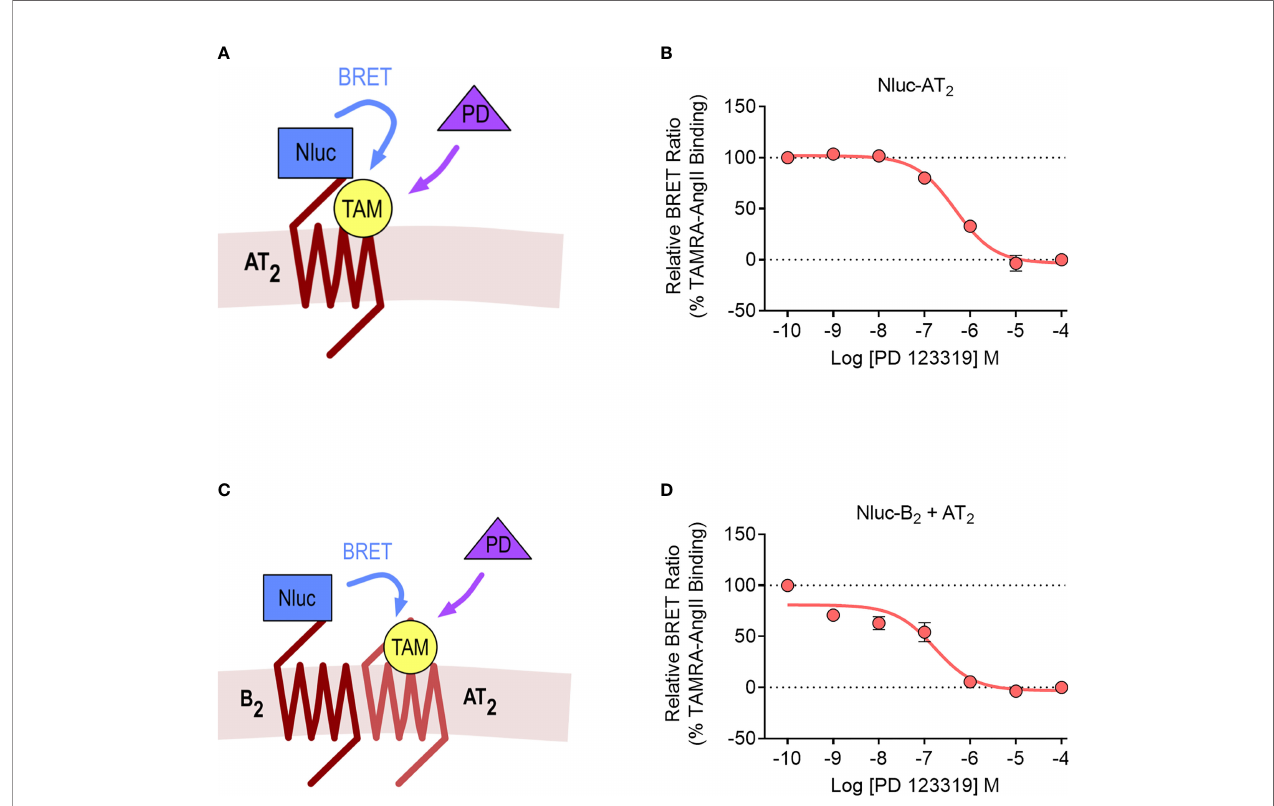
FIGURE 7 | NanoBRET assay for detection of ligand binding to the AT 2 receptor and the AT 2 -B 2 heteromer. Depiction of the NanoBRET assay for detection of TAMRA-AngII (TAM) ligand binding to Nluc-AT 2 (A) and AT 2 receptors heteromerized with B 2 receptors (using the Receptor-HIT assay) (C) . HEK293FT cells were transfected with Nluc-AT 2 and pcDNA3 (B) or Nluc-B 2 and AT 2 (D) and competition binding assays were conducted with TAMRA-AngII and PD 123319. Data are presented as mean ± SEM of ≥ three independent experiments performed in